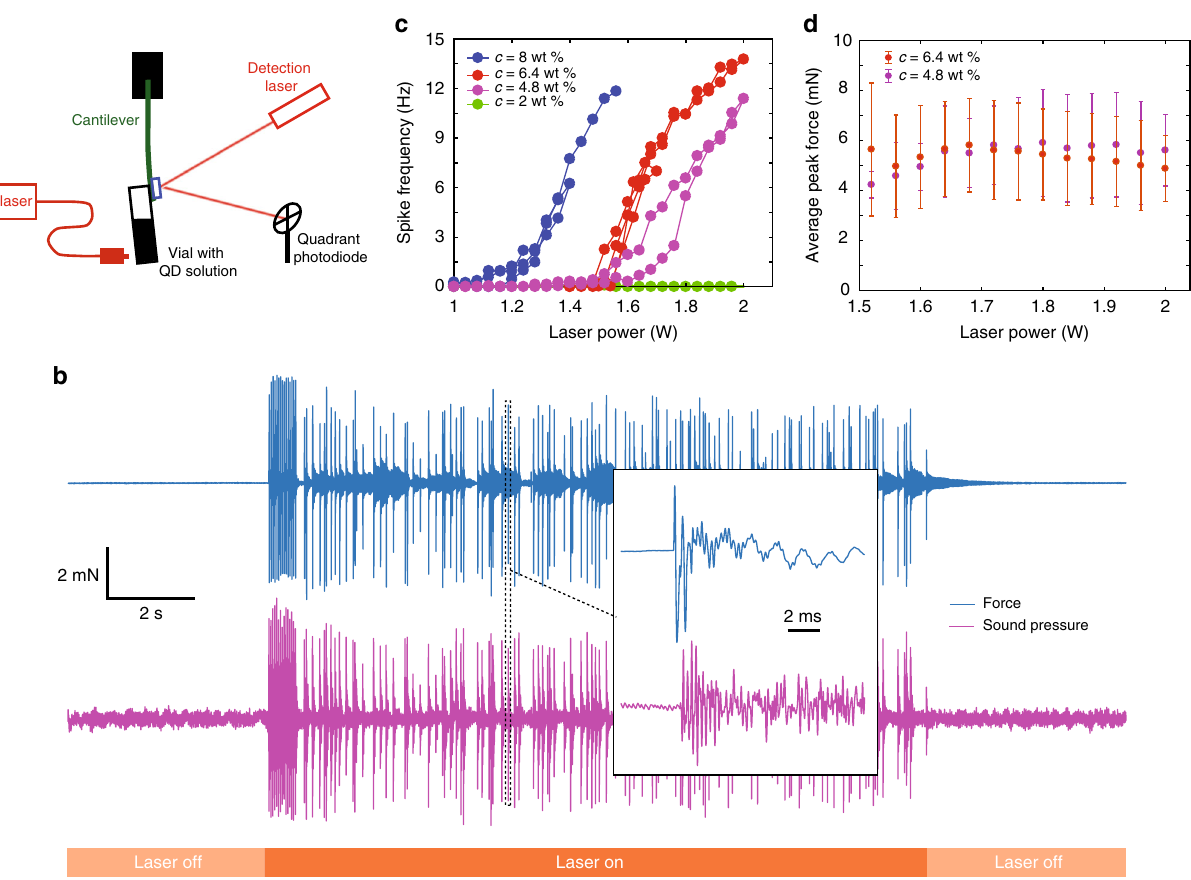
Fig. 2 Cantilever-based measurements of the laser-induced force. a Schematic of the experimental setup. The vial is suspended on a cantilever; a low power laser and a quadrant photodiode are used to monitor the cantilever position as a function of time. b Typical force and sound pressure vs. time measurement. The particle concentration is 6.4wt% and the laser power is 1.5W. Inset: zoom on a single force spike and the corresponding spike in sound pressure. c Frequency of the force spikes as a function of laser power, for different particle concentrations. Spikes are observed above a critical laser power, which increases with decreasing concentration. d Average peak force as a function of laser power, for two different particle concentrations. Error bars represent the